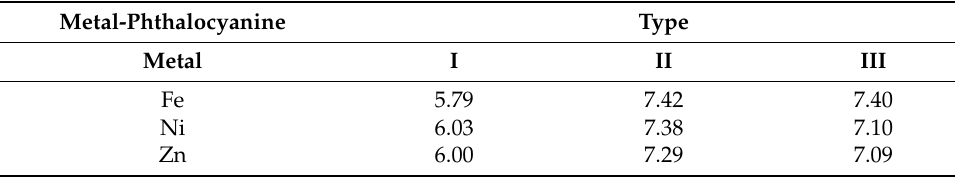
Table 3. HOMO–LUMO gap (eV) (HF/LanL2DZ level of